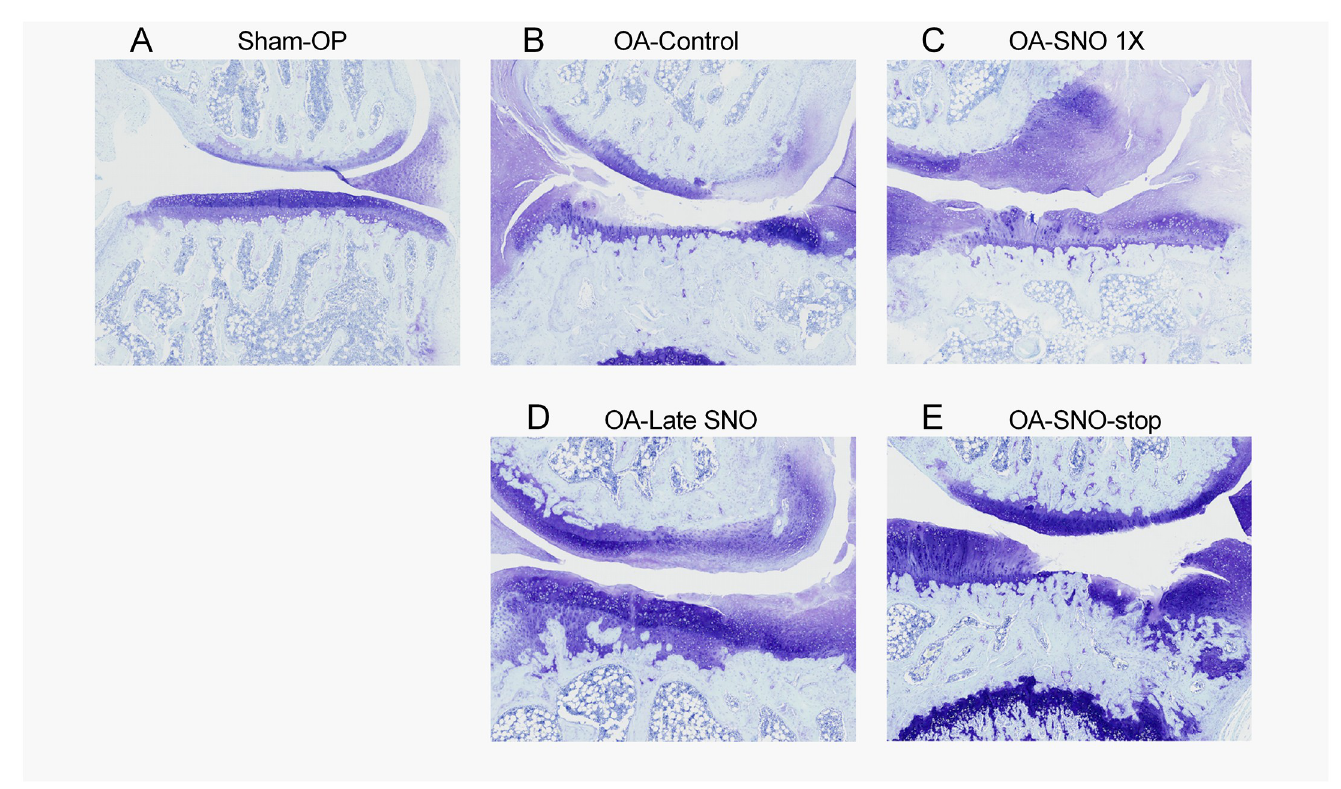
Fig 4. SheaFlex75 delays histopathological changes in the OA knee joint. Histological sections from OA knees from the sham-OP (A), OA-control (B), OA-SNO 1X (C), OA-Late SNO (D), and OA-SNO-stop (E) rats at week 24 post-surgery. The histological sections were processed with toluidine/fast green staining.